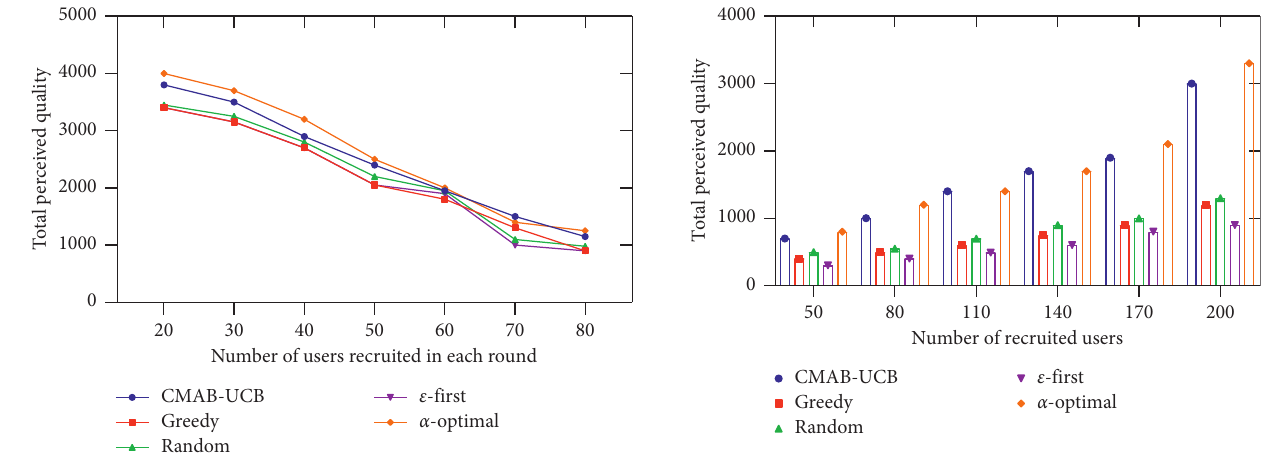
Figure 4: The relationship between perceived quality and user recruitment in each round ( b � 15000).